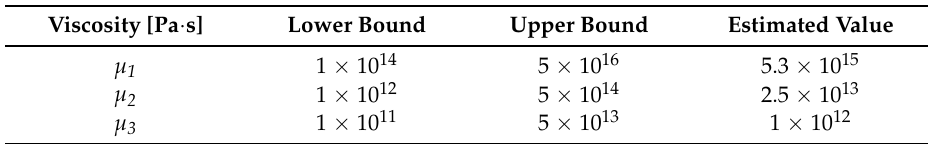
Table 1. Input Parameters: Physical and Mechanical Properties of the Geo-Mechanical Units. Rock Material Density [kg/m 3 ] Young’s Modulus [MPa] Poisson Ratio [–] Viscosity [Pa · s] Limestone bedrock 2200 8 × 10 3 0.28 1 × 10 22 Pelitic-Sandstone bedrock 1850 Debris deposit Colluvial deposit Shear band 0.23 – Table 2. Optimized Parameters. Physical Parameters Bounds Used for the Shear Band Sectors in the Optimization and the Best Estimated